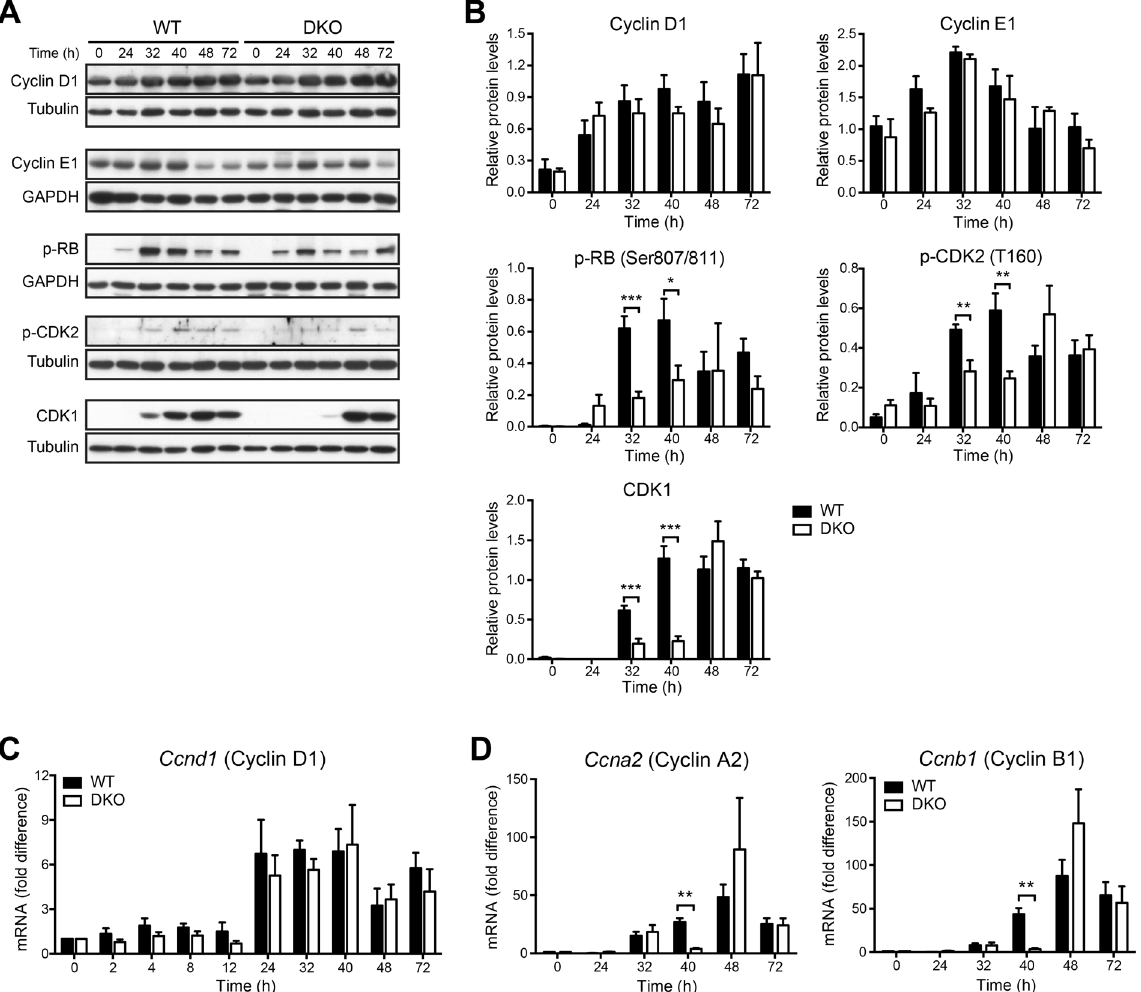
Figure 4. Impaired cell cycle progression in mice with defective cytosolic nucleic acid sensing pathways. Total protein extracts of liver samples were analysed by Western blotting using antibodies against cyclin D1, cyclin E1, p-RB, p-CDK2, or CDK1. Representative gels (A) and densitometric analyses (B) are depicted. Cropped gels are shown. Full length gels are available in the supplemental information. Hepatic mRNA expression of cyclin D1 (two-tailed unpaired Student’s t-test or the Mann-Whitney U